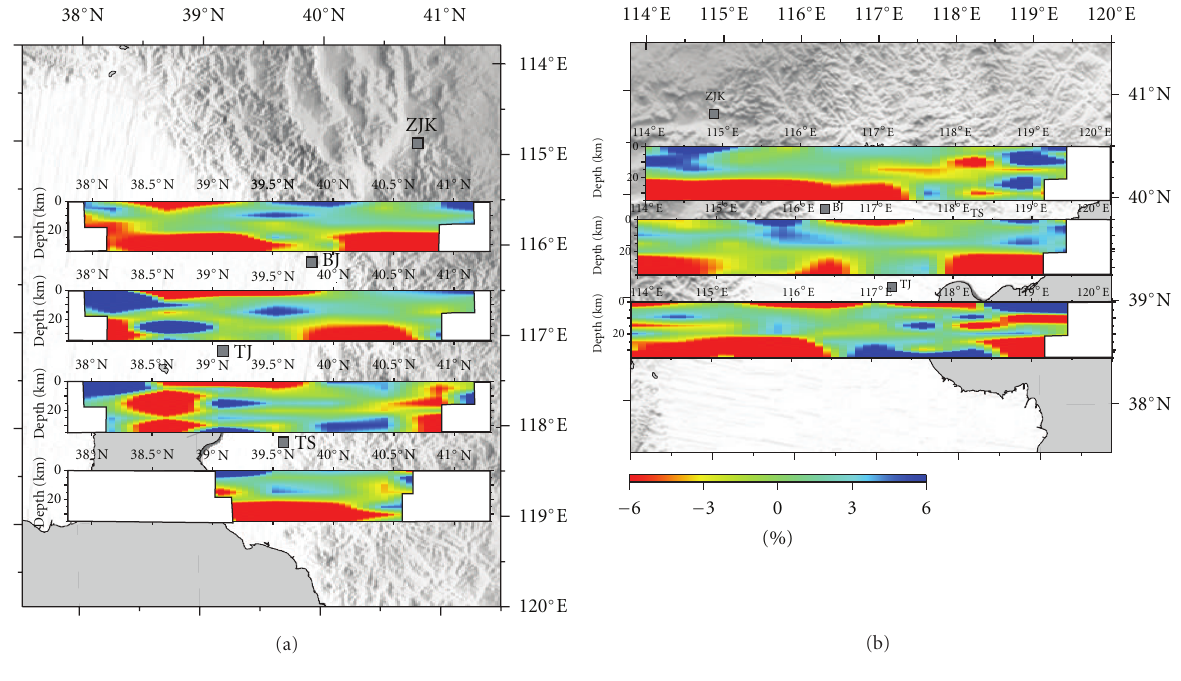
Figure 7: Vertical cross-sections of P wave velocity perturbation at each longitude (115.5 ◦ E, 116.5 ◦ E, 117.5 ◦ E, and 118.5 ◦ E) (a) and each latitude (40.5 ◦ N, 39.8 ◦ N, and 39.0 ◦ N) (b). Red and blue colors denote slow and fast-velocity anomalies, respectively. The velocity perturbation scale (in %) is shown at the bottom. BJ: Beijing; TJ: Tianjin; TS: Tangshan; ZJK: Zhangjiakou; SJZ: Shijiazhuang.